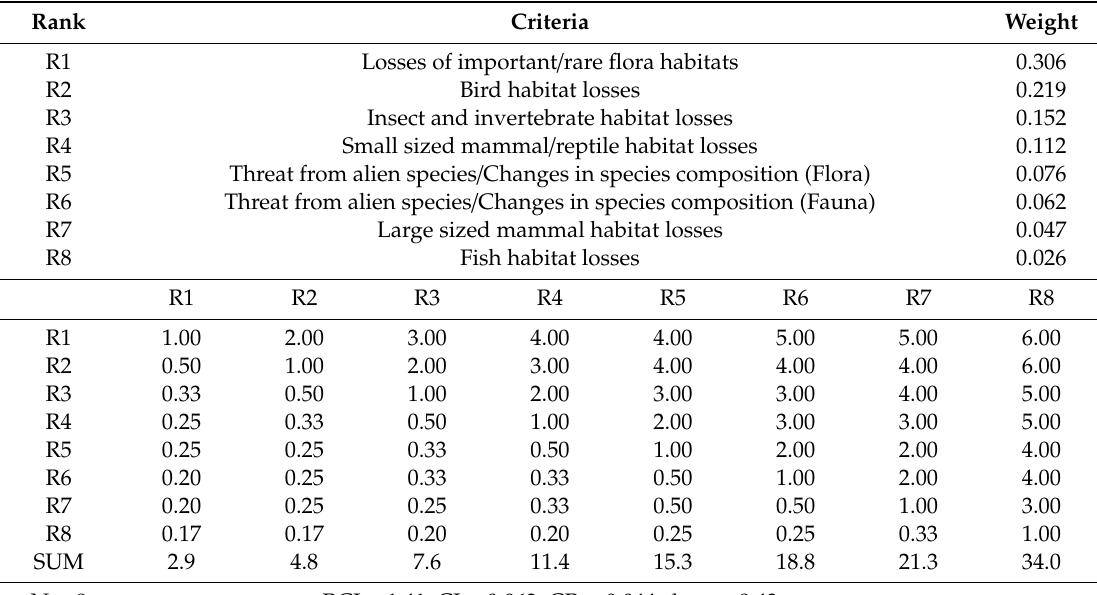
Table A9. Pair-wise comparison reciprocal matrix for the general environmental impacts fire e ff ects category. RCI: random consistency index; CI: consistency index; CR: consistency ratio; λ max : principal eigenvalue.